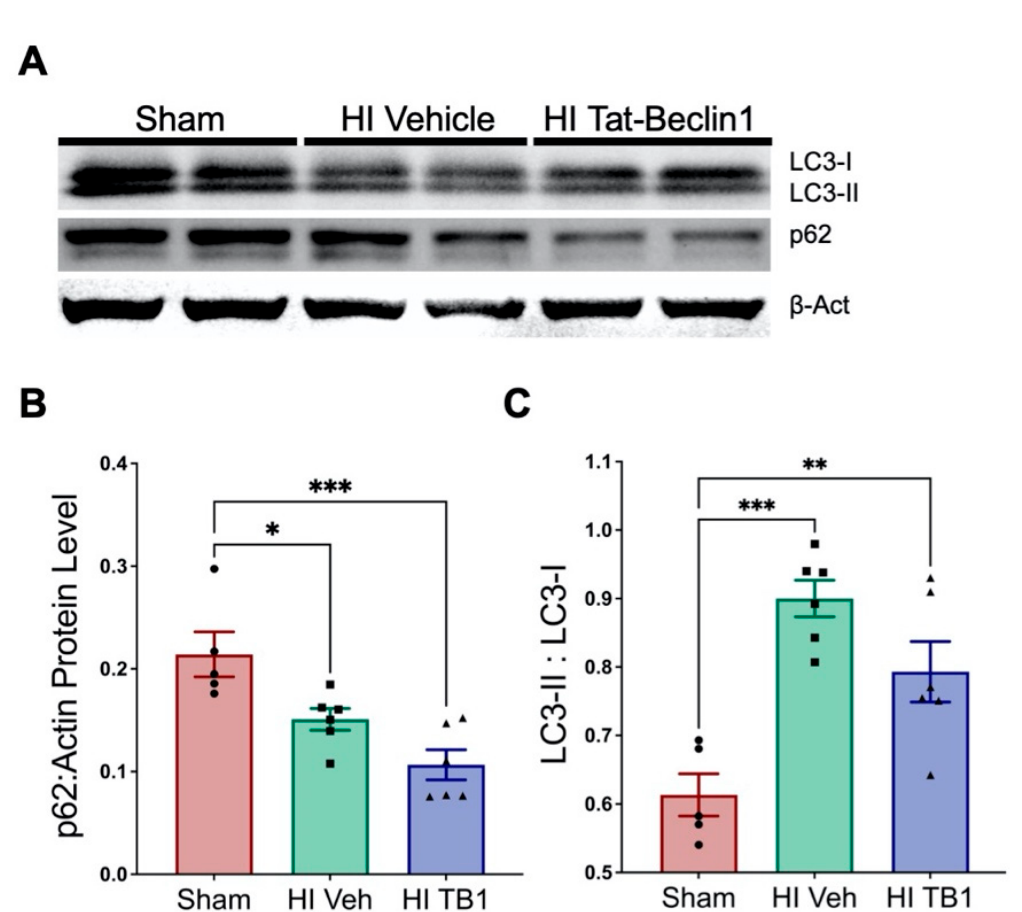
Figure 3. Systemic Tat-Beclin1 administration induced autophagy in the brain up to 48 h after injection. Three days after HI, rat pups were injected i.p. with Tat-Beclin1 (15 mg/kg, TB1) or vehicle (PBS). 48 h after injection, samples of the injured forebrain were prepared for Western blot. ( A ) Representative blot for LC3, p62, and β -Actin (loading control) from the injured hemisphere. ( B ) Quantitative analysis of band optical densities for p62 and ( C ) ratio of LC3-II/LC3-I band densities (Sham n = 5/group; Treatment n = 6/group). Data are presented as means ± SEM; * p < 0.05, ** p < 0.001 as determined by one-way ANOVA followed by Tukey’s multiple comparison